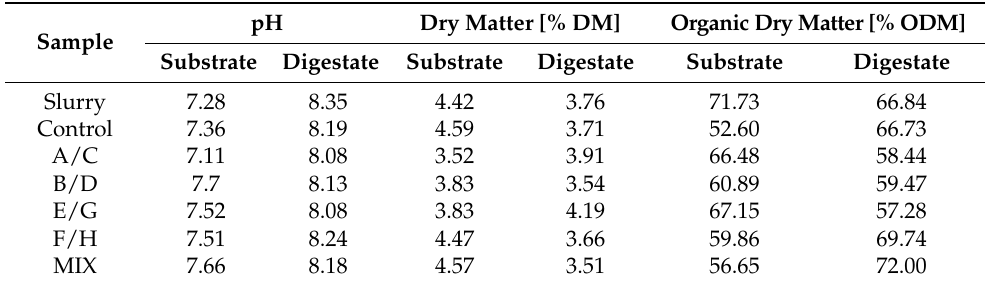
Table 2. Physicochemical parameters of substrates used for the experiment and achieved fer ‐ mented material.